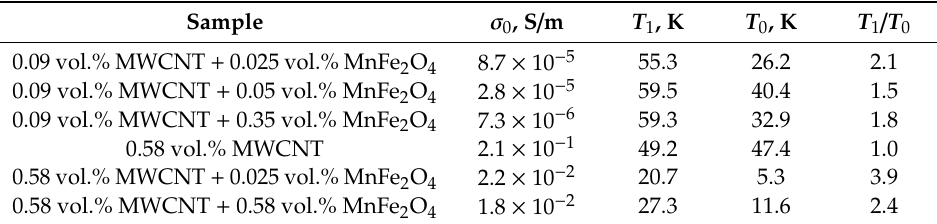
Table 2. Tunneling model